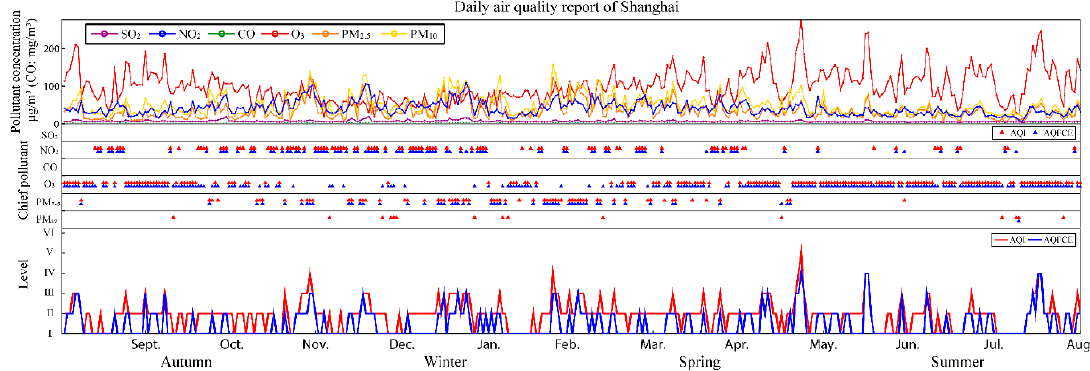
Figure 5. Daily pollutant concentration variation and air quality evaluation result of chief pollutant and level of Shanghai.